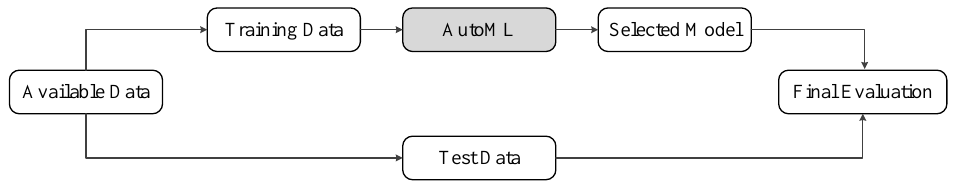
Figure 1. Proper performance evaluation of AutoML techniques, by holding out part of the available data as a test